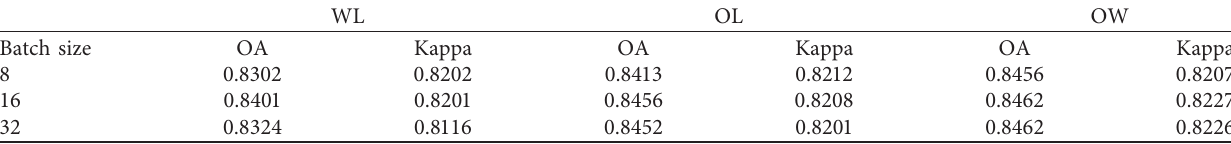
Table 4: Accuracy comparison of different batch sizes.